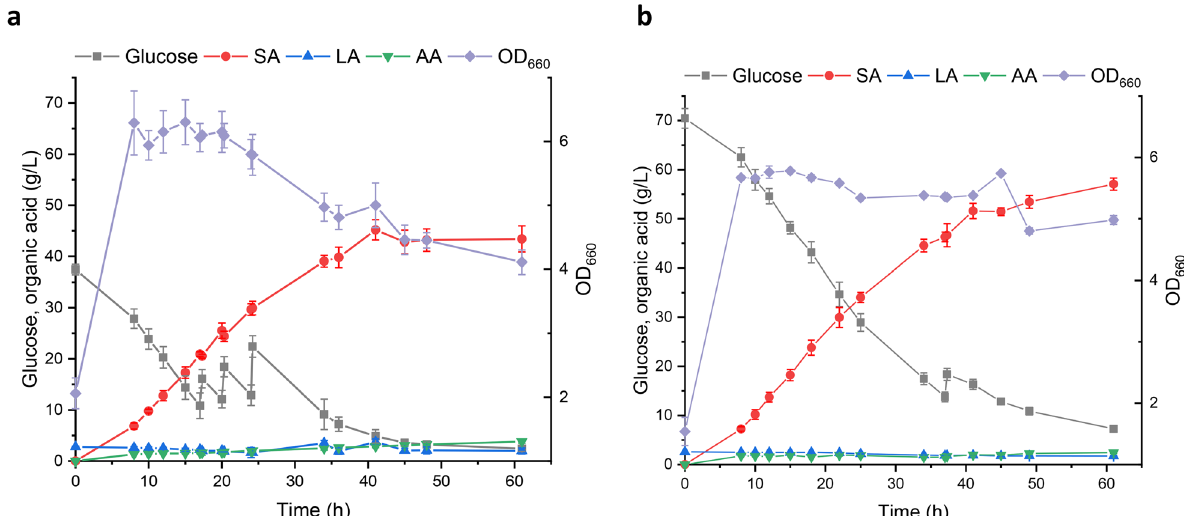
Fig. 5 Time courses of SA production in a 3L-scale fed-batch fermentation: 40 g/L initial glucose concentration ( a ); 80 g/L initial glucose concentration ( b ). Results are the means of at least three independent assays and error bars indicate the standard